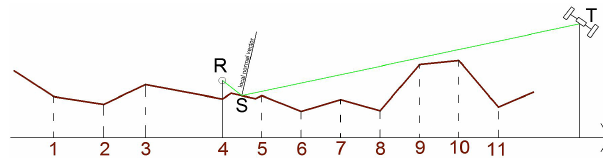
Figure 5. Determination of the specular reflection point integrating a DEM. S : specular reflection point position. R : receiver position.